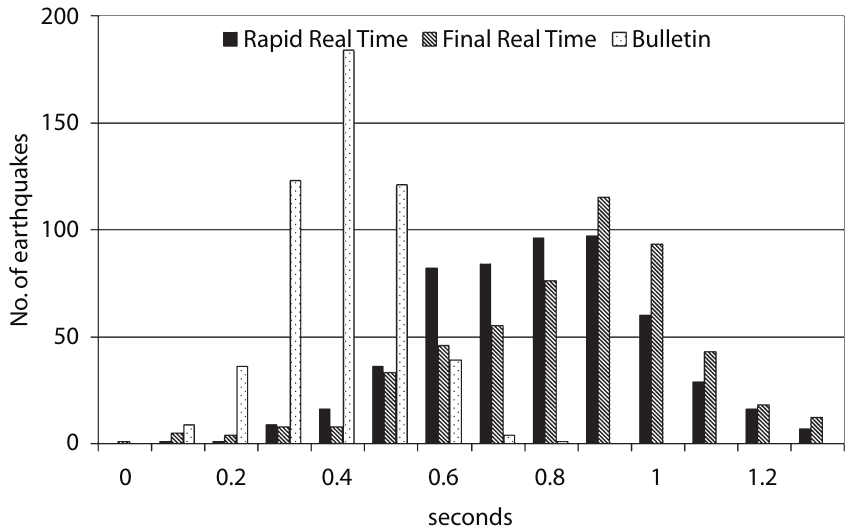
Fig. 5. Distributions of the weighted RMS of the residuals for Bulletin, final realtime, and rapid realtime loca- tions in